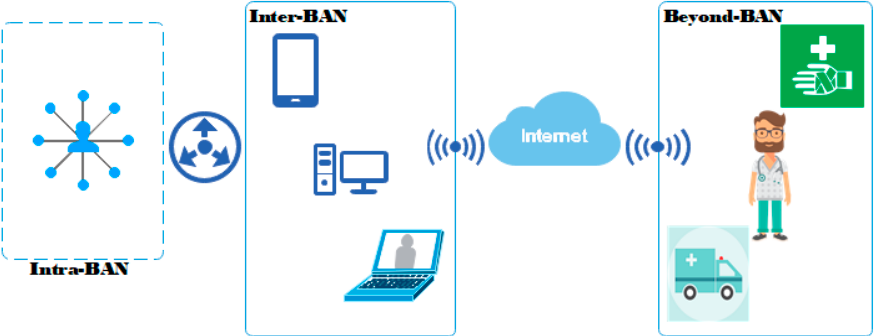
Figure 1. Wireless body area network (WBAN) architecture for e-health applications illustrating the existing types of communication.